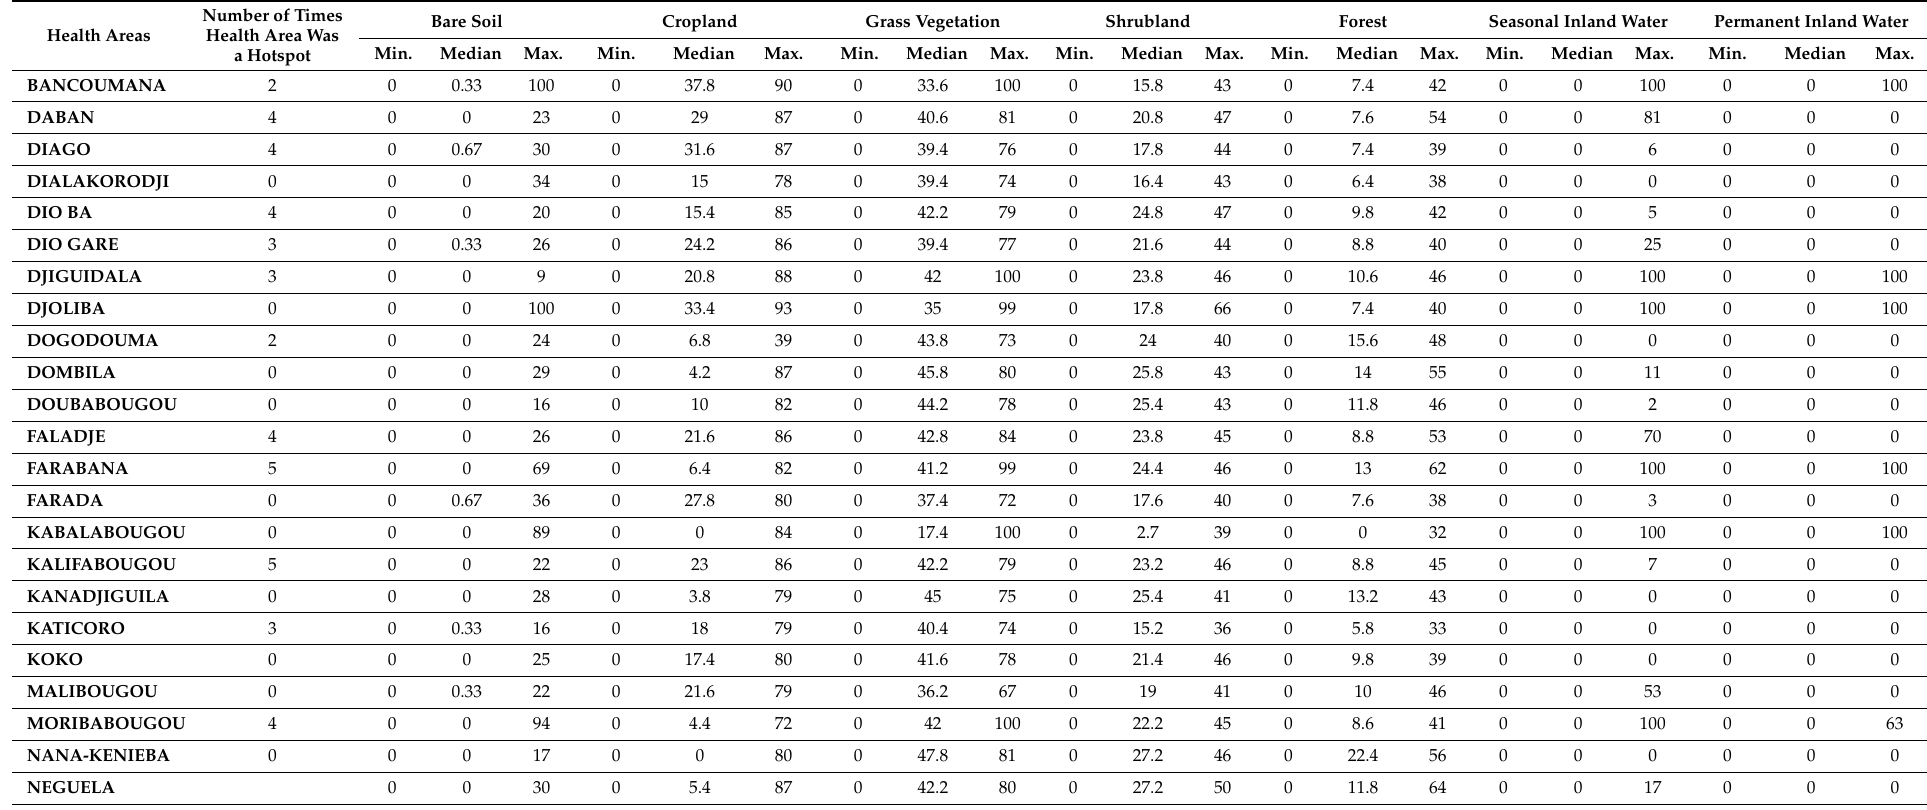
Table 4. Health areas according to the number of times they were a hotspot and their land cover characteristics. Health